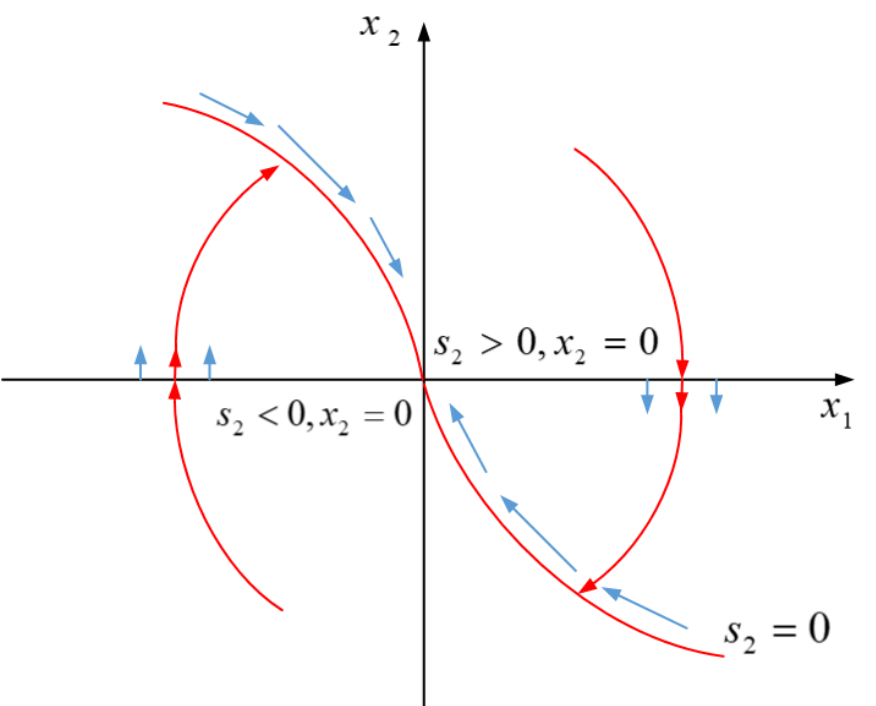
Figure A1. The phase plot of the system with NTSM controller [34]. The equipment used in the experimental setup of a DC-DC buck converter feeding a voltage-controlled boost converter is listed in Table A1. This boost converter acts as a CPL. Table A1. The equipment of the voltage-controlled boost converter. Table A1. Equipment used in the experimental setup. N The Equipment 1 DC-DC buck converter 2 DC-DC boost converter